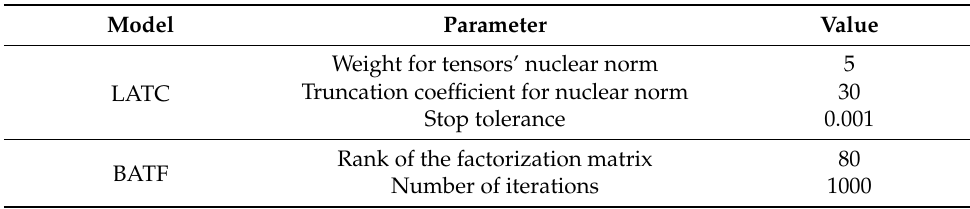
Table 6. Main parameters of the compared imputation